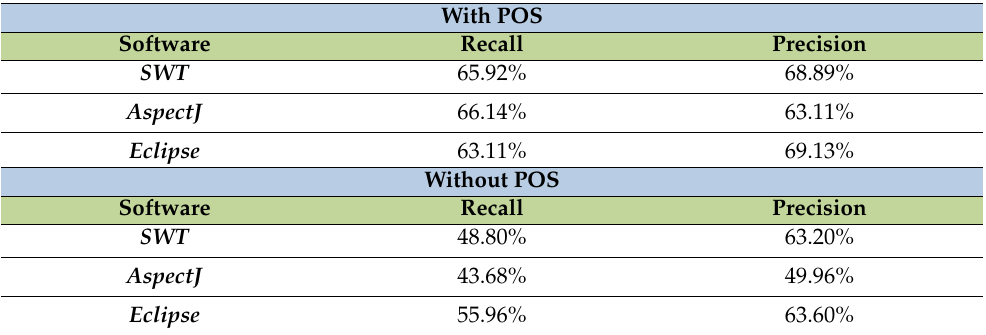
Table 3. Recall and precision for